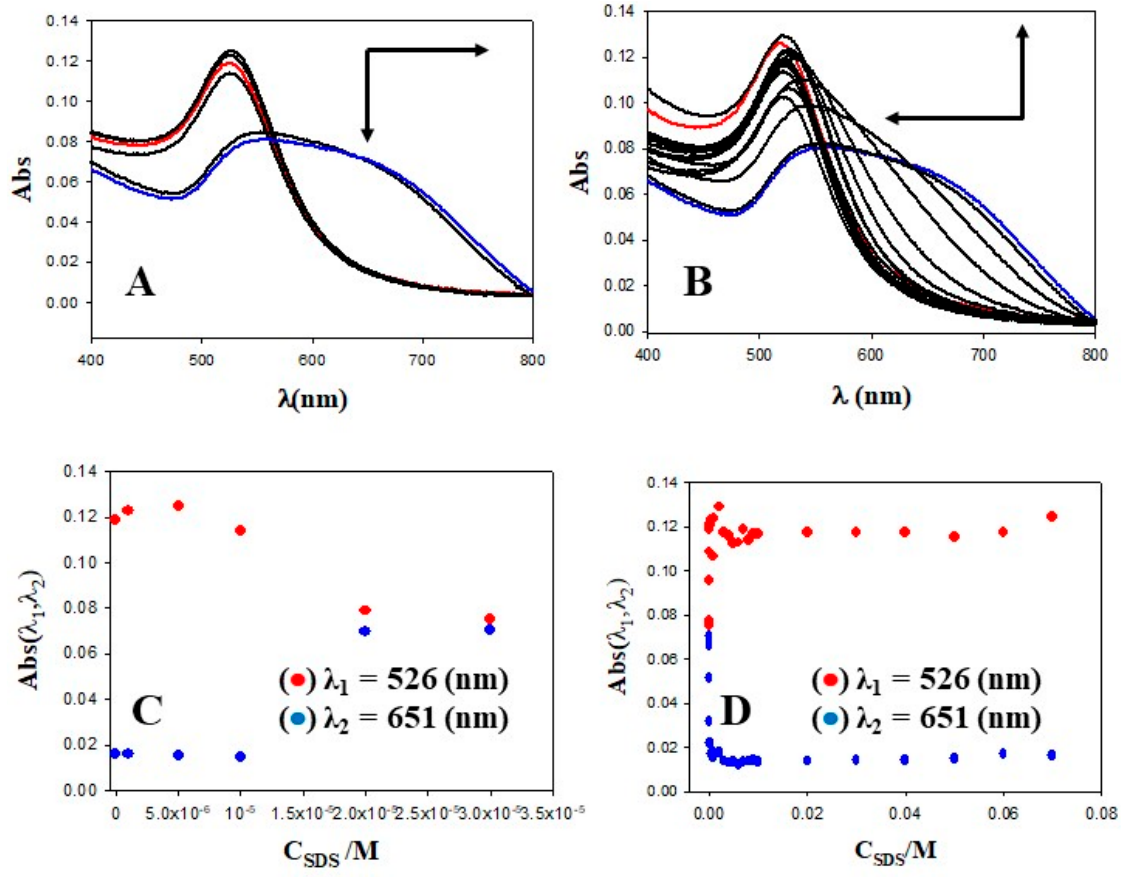
Figure 1. Absorbance titration of the Au@16-3-16/SDS system at a fixed C Au@16-s-16 = 1.74 × 10 − 8 M concentration and its corresponding absorbance intensities at λ 1 = 526 nm and λ 2 = 651 nm wave- lengths. ( A ) Aggregation experiments. Red spectrum, C SDS = 0 µM; blue spectrum, C SDS = 30.0 µM; black-spectrum arrow direction, C SDS = 1.0, 5.0, 10.0 and 20.0 µM. ( B ) Disaggregation experiments. Red spectrum, C SDS = 0.07 M; blue spectrum, C SDS = 30.0 µM; black-spectrum arrow direction, C SDS = 40.0 µM, 50.0 µM, 60.0 µM, 75.0 µM, 10.0 mM, 50.0 mM, 75.0 mM, 1.0 mM, 2.0 mM, 3.0 mM, 4.0 mM, 5.0 mM, 6.0 mM, 7.0 mM, 8.0 mM, 9.0 mM, 0.01 M, 0.02 M, 0.03 M, 0.04 M, 0.05 M, and 0.06 M. ( C ) Absorbance intensities of aggregation experiments versus C SDS . ( D ) Absorbance intensities of dis- aggregation experiments versus C SDS .